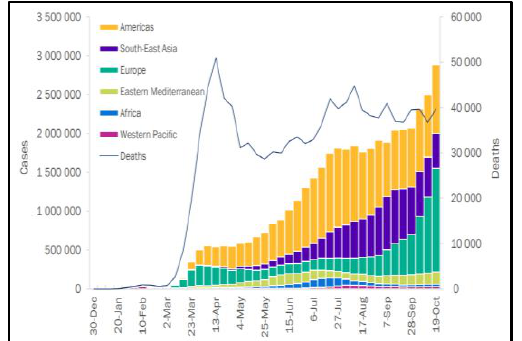
Figure 1. Number of COVID-19 cases reported weekly by WHO Region and global deaths (data as reported at on 19 October 2020) (9) .